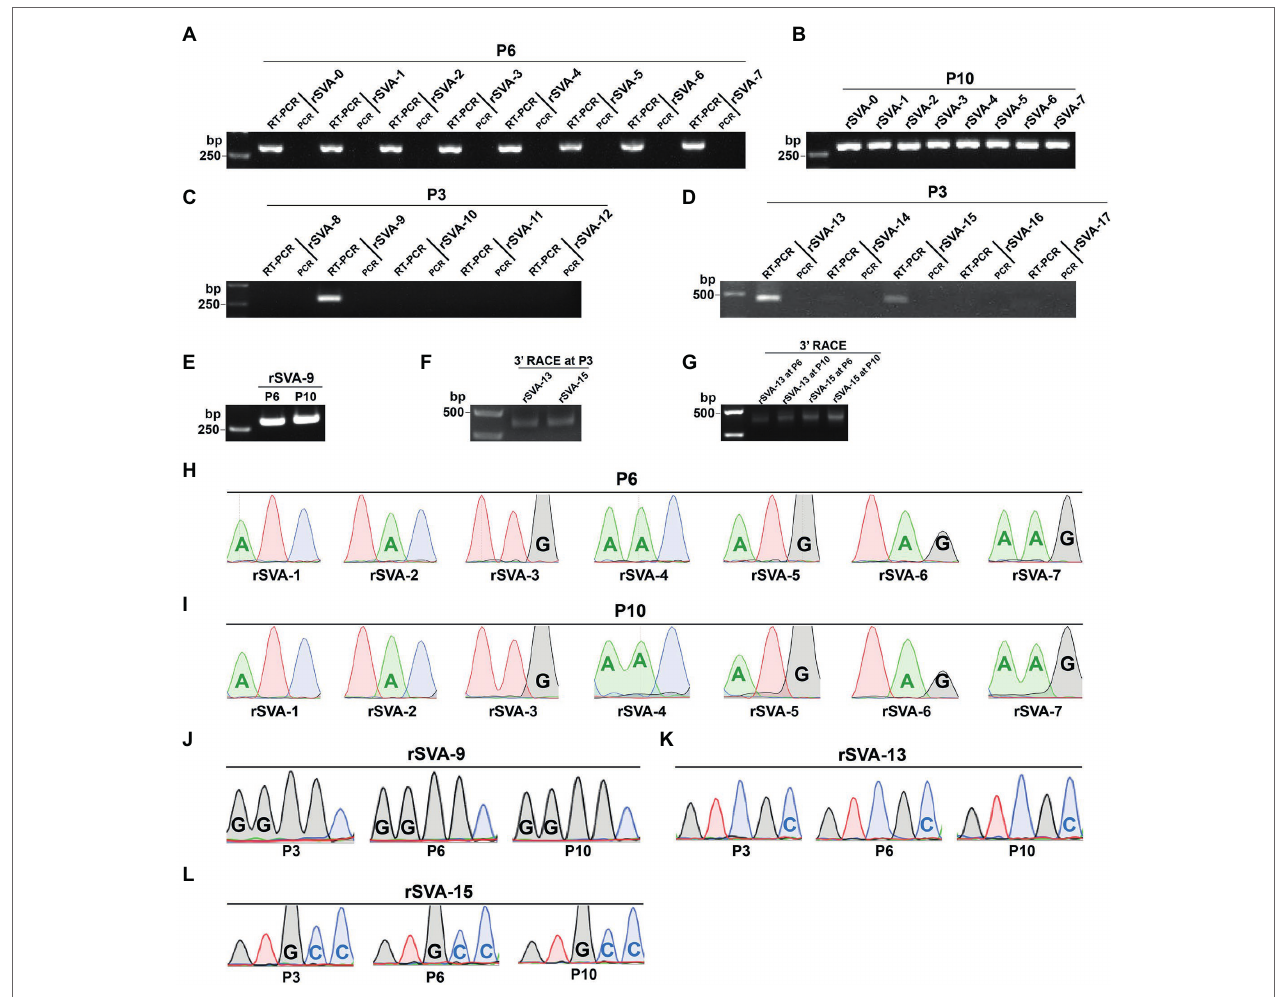
FIGURE 5 | Identification of replication-competent rSVAs rescued from their individual cDNA clones. RT-PCR detection of rSVA-0 to − 7 at P6 (A) and P10 (B) . PCR analysis is simultaneously performed to demonstrate no interference of plasmid residues, the same below. RT-PCR detection of rSVA-8 to − 12 (C) and − 13 to − 17 (D) at P3. RT-PCR detection of rSVA-9 at P6 and P10 (E) . 3’-RACE reaction of rSVA-13 and -15 at P3, P6, and P10 (F,G) . Sanger sequencing chromatograms of RT-PCR products from rSVA-1 to − 7 samples at P6 (H) and P10 (I) . Sanger sequencing chromatograms of RT-PCR products from three rSVA-9 samples (J) . Sanger sequencing chromatograms of 3’-RACE reaction products from rSVA-13 (K) and − 15 (L)